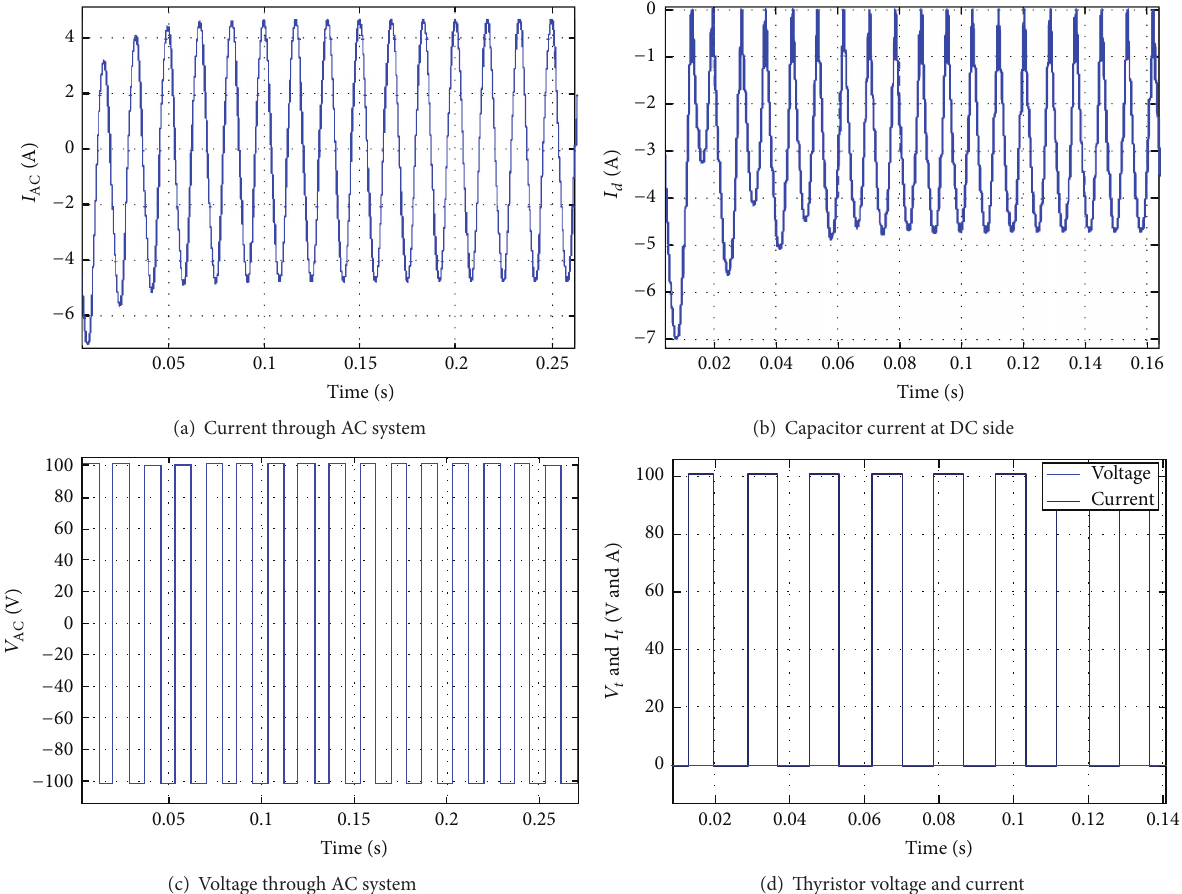
Figure 14: Simulation results of VSC single phase with constant voltage source (DC and AC